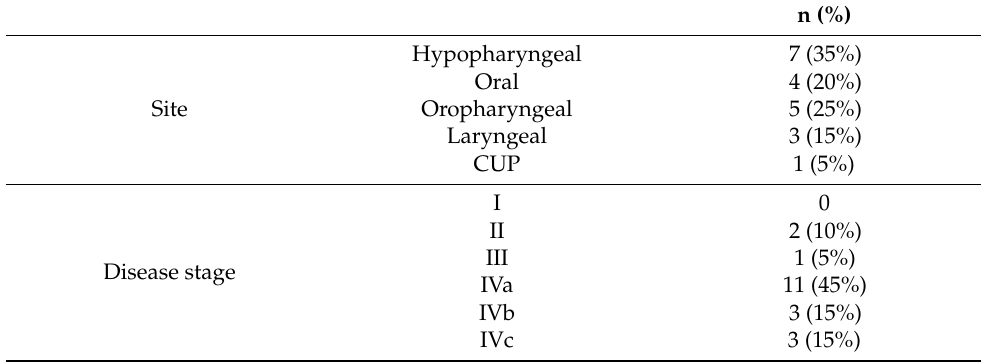
Table 2. Tumor site and stage of disease in the cancer group. CUP: carcinoma of unknown primary.